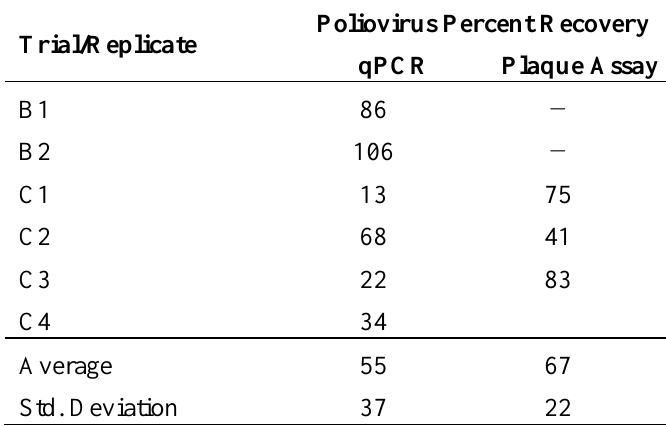
Table 4. Percent Recovery of Poliovirus qPCR vs. plaque assay. Recoveries incorporate differences in extraction and detection